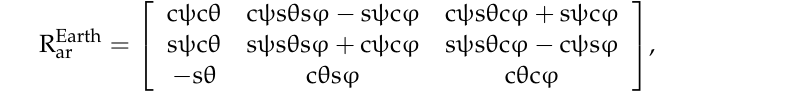
The joint angles of the aerial robot arm are Γ ra =